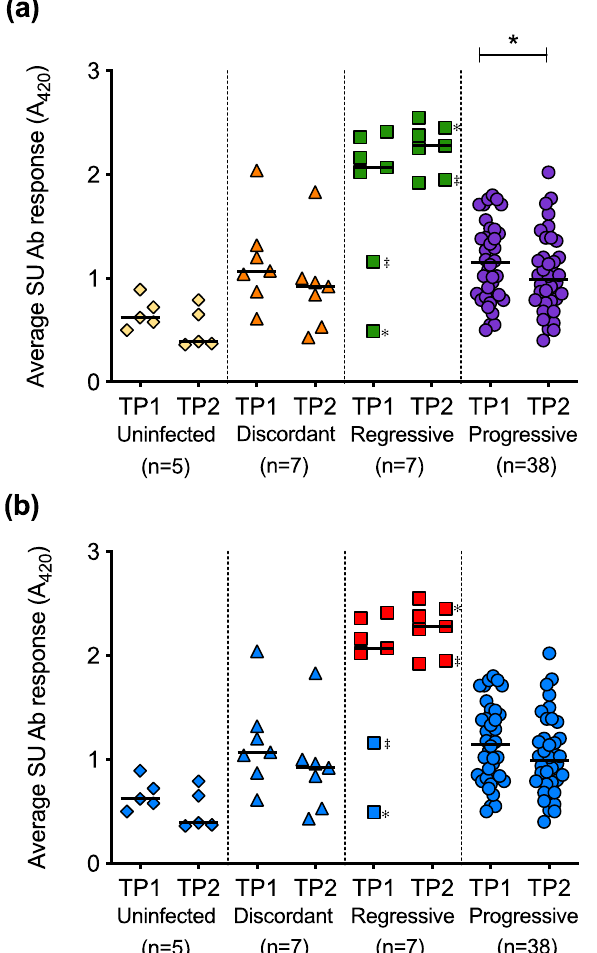
Figure 13. Longitudinal analysis of average SU antibody responses and VNA responses. ( a ) For paired samples, average anti-SU responses calculated at timepoint 1 (TP1) and timepoint 2 (TP2) are shown. ( b ) All plasma samples were then tested for virus neutralising antibodies (VNA). Two cats with regressive infection (‡ and *) seroconverted from negative to positive between TP1 and TP2. Statistical significance was determined using Wilcoxon matched-pairs signed rank test ( p -value < 0.05 *). When anti-FeLV-A SU antibody responses were compared to anti-FeLV-B SU antibody responses, it was observed that samples that tested positive for VNA clustered together, demonstrating high antibody responses to both SU proteins (Figure 14). VNA titres were detected in 15 of the 17 samples from cats with regressive infection. All VNA-positive cats showed VNA titres of ≥